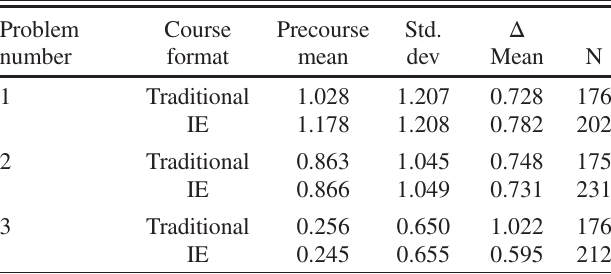
TABLE IV. Precourse execution accuracy scores (and standard deviations) and increase in postcourse execution accuracy scores for sample of IE physics students matched to the traditional physics students on the precourse accuracy scores. ( Δ Mean indicates the average of the difference between each student ’ s pre and postcourse score.)